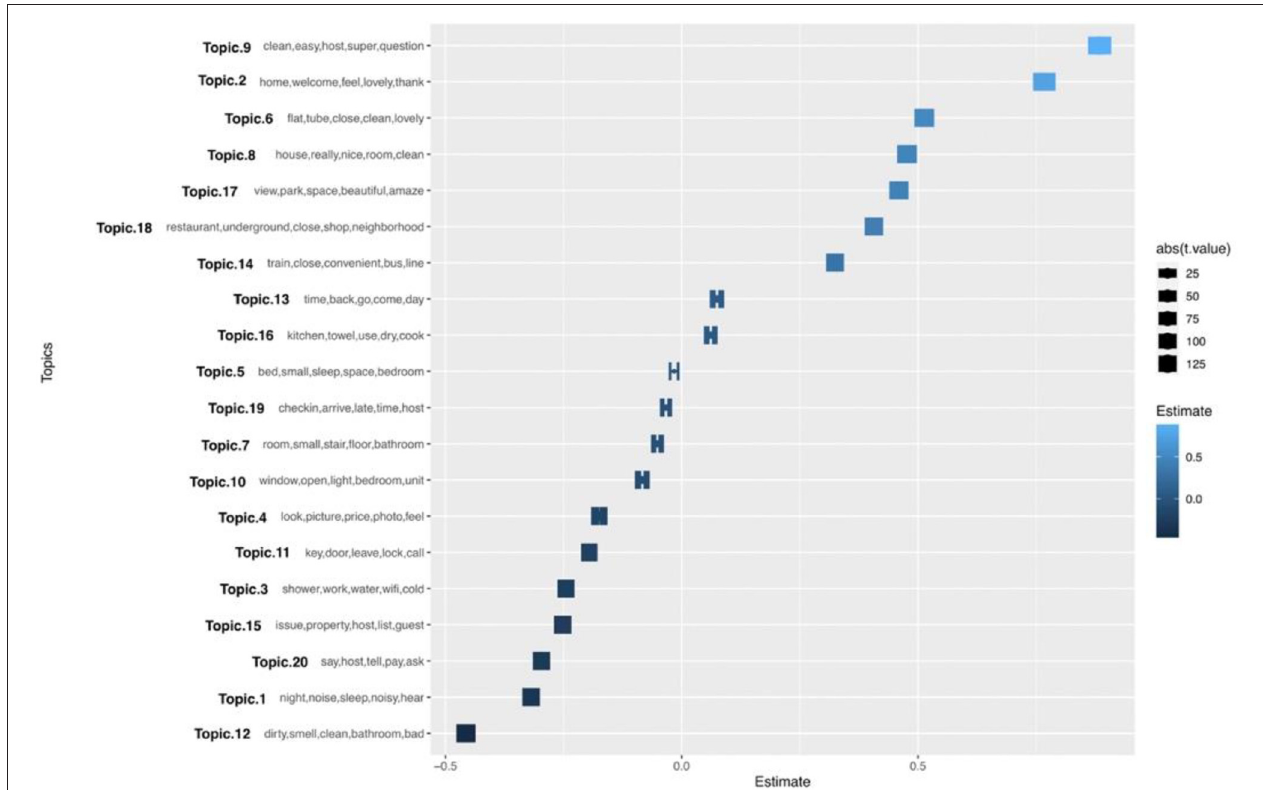
FIGURE 10 | sLDA visualization. Source: created by the authors.